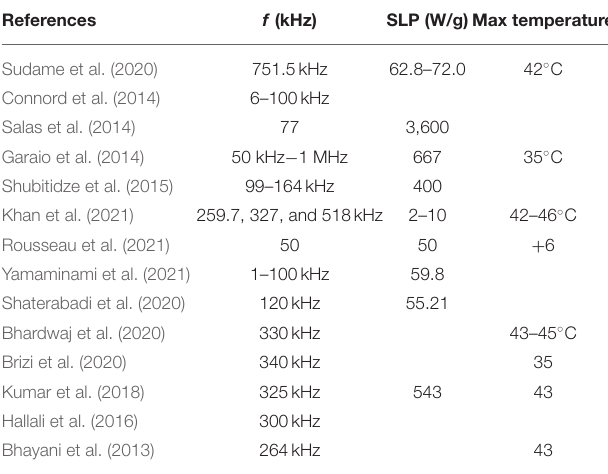
TABLE 1 | Typical parameters used in hyperthermia